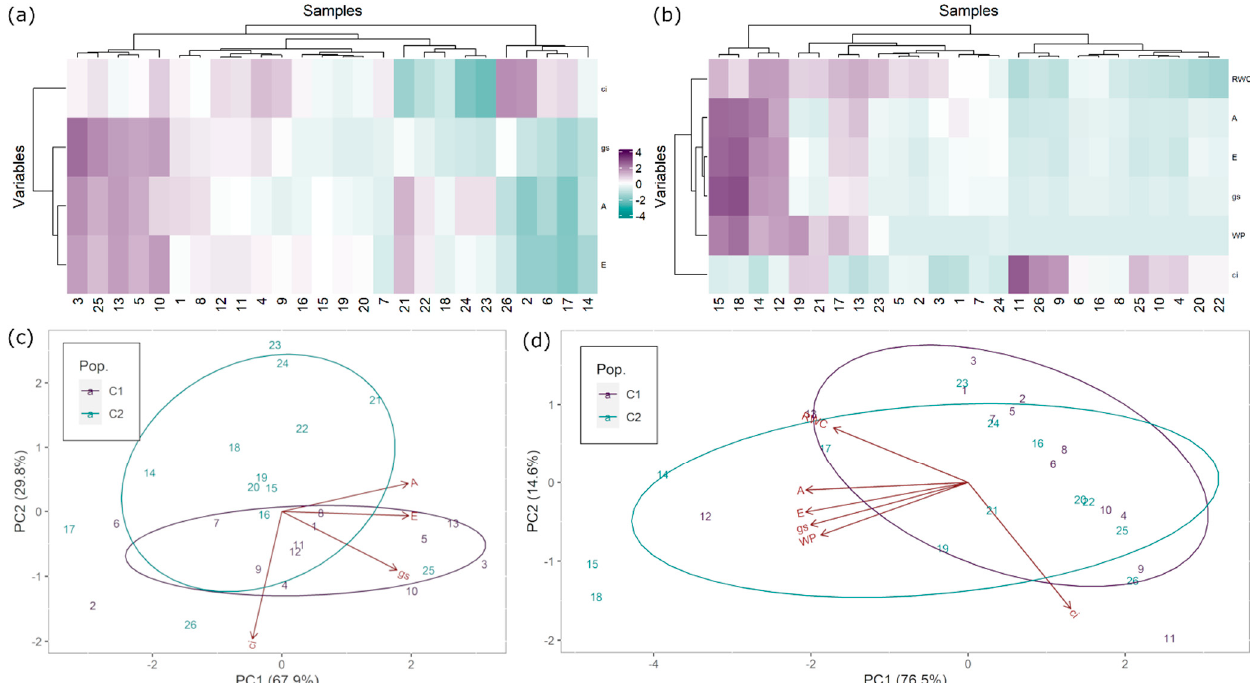
Figure 7. Physiological parameters measured on 26 hybrid plants from populations C1 and C2 on t0 and t3 (3 weeks under water deficit): ( a , b ) heatmap with dendrogram on t0 and t3; ( c , d ) principal component analysis (PCA) on t0 and t3. ci—intercellular CO 2 concentration, E—transpiration rate, gs—stomatal conductance, A—net CO 2 assimilation rate, RWC—relative water content, WP—water potential.